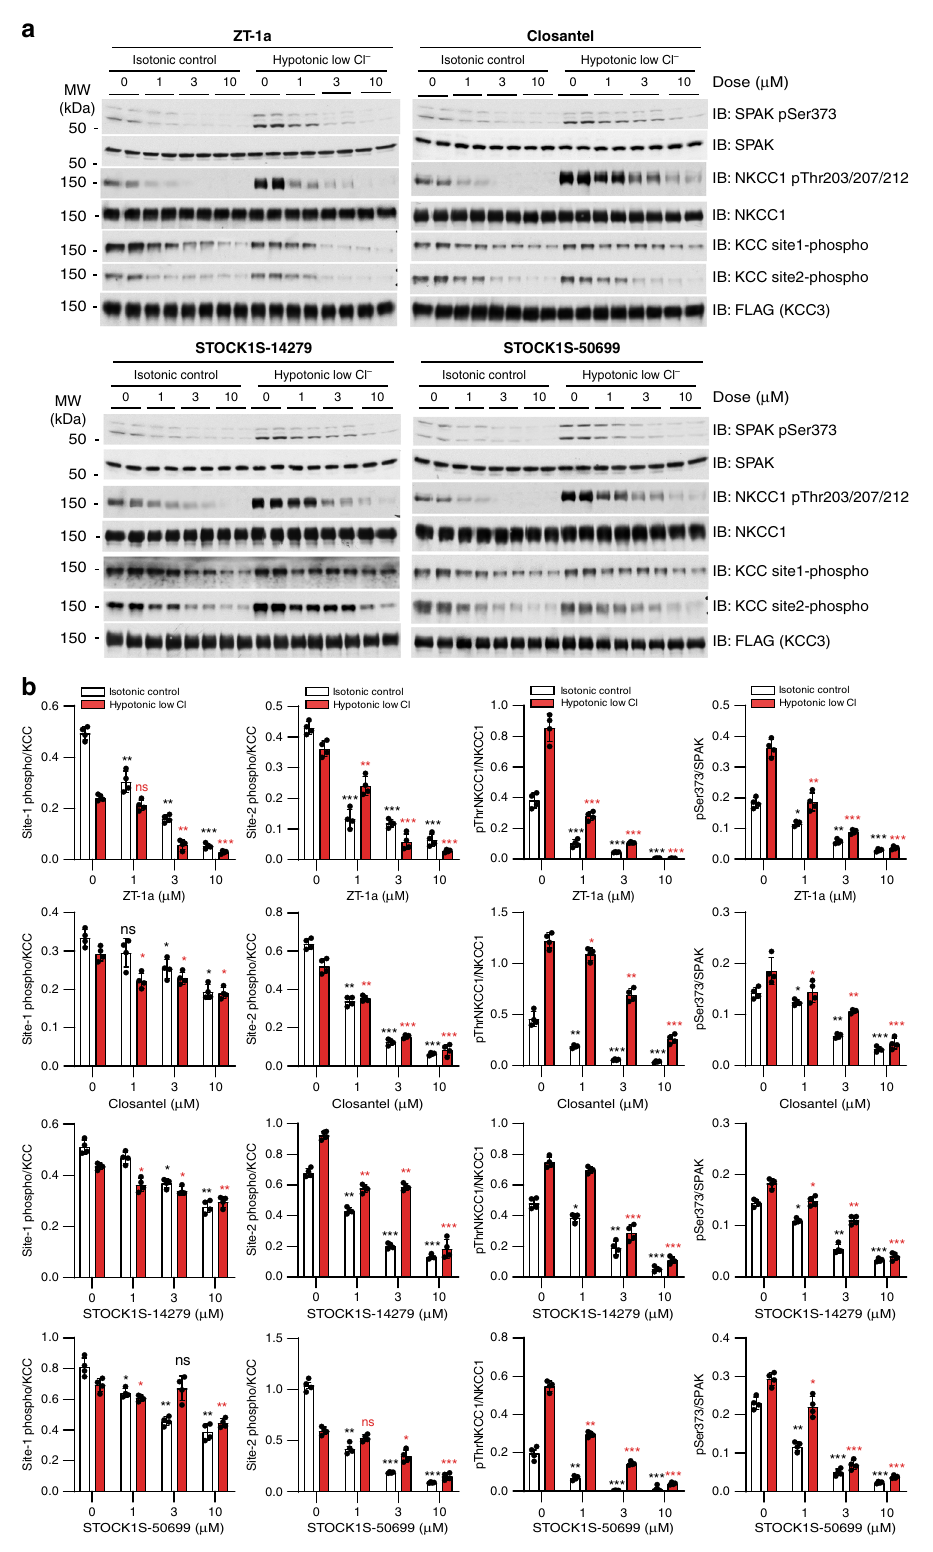
Fig. 2 ZT-1a suppresses CCC phosphorylation. a ZT-1a dose dependently inhibited KCC3 Thr991/Thr1048 phosphorylation in cells. HEK-293 cells were transfected with a DNA construct encoding wild-type N-terminally FLAG-tagged KCC3. Cells at 36 h post transfection were exposed for 30 min to either control isotonic or hypotonic low [Cl − ] conditions, and then treated in the same conditions for an additional 30 min in the presence of inhibitors at the indicated concentrations. Cell lysates were subjected to SDS-PAGE and immunoblot with the indicated antibodies. b Immunoblot quantitation on ZT-1a, Closantel, STOCK1S-14279, and STOCK1S-50699. Band intensities were quantitated with ImageJ software. *** p < 0.001; ** p < 0.01; * p < 0.05; ns, nonsigni fi cant [by one-way ANOVA with post hoc testing ( n = 6, error bars represent the mean ±